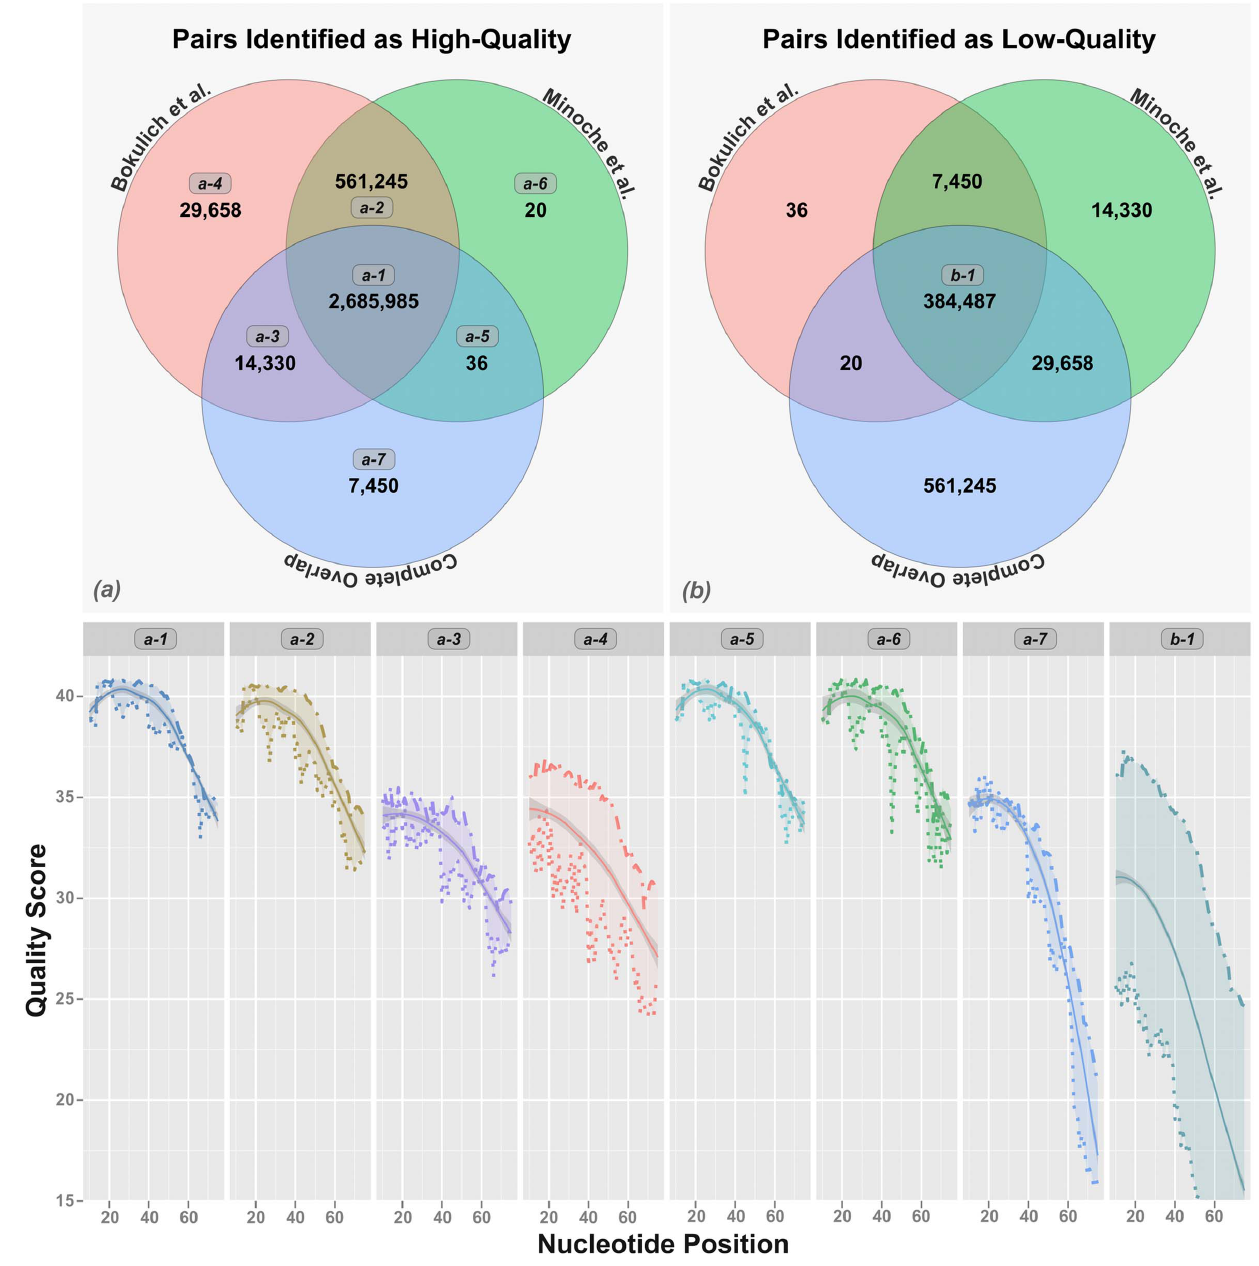
Figure 3. Paired-end reads from 33 samples that passed and failed the quality filtering by individual methods are compared in Venn diagrams. The mean quality scores of paired-end reads from the numbered regions in Venn diagrams are shown below. In each panel, the top and bottom lines show read 1 and read 2, respectively. The mean quality of each pair at each nucleotide position is also shown with a smooth